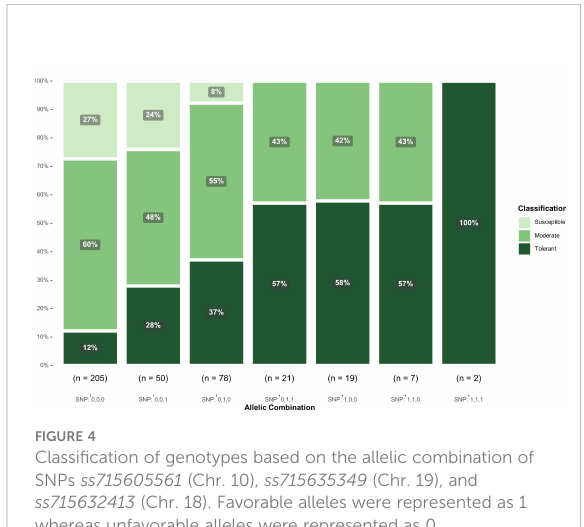
FIGURE 4 Classi fi cation of genotypes based on the allelic combination of SNPs ss715605561 (Chr. 10), ss715635349 (Chr. 19), and ss715632413 (Chr. 18). Favorable alleles were represented as 1 whereas unfavorable alleles were represented as